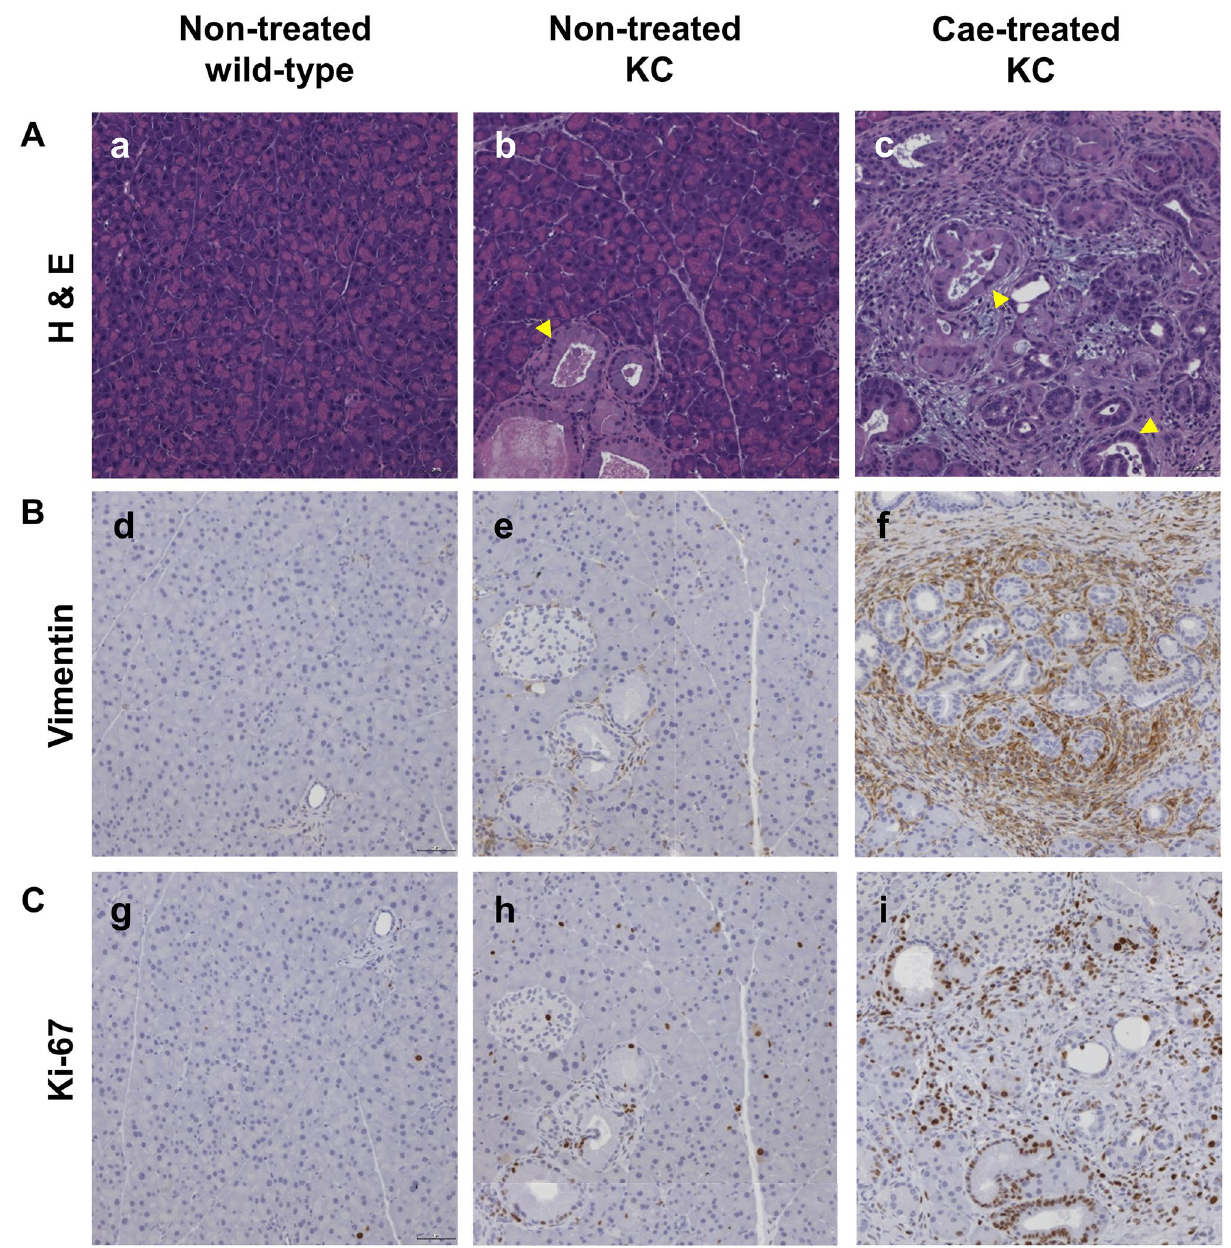
Figure 2. General pathological characteristics of PanIN lesions in a genetically engineered mouse model. Different staining images of pancreas histology at 10 × magnification in non-treated wild-type mice (n = 3), non-treated LSL-Kras G12D ; PDX-1-Cre (KC) transgenic mice (n = 4), and caerulein-treated KC transgenic mice (n = 5). ( A ) H&E stained section of the pancreas shows architectural and cytological changes of the smaller duct, including tall columnar cells (arrow), papillary formations, variation in nuclear size (pleomorphism), and nuclear hyperchromasia in KC transgenic mice (b, c). ( B ) Vimentin is mainly expressed around the pancreas duct and the surrounding area in KC transgenic mice (e, f). ( C ) Increasing Ki-67 positive acinar cell number is observed in KC transgenic mice (h, i). Cae, caerulein; H&E, Hematoxylin and eosin; KC , LSL-Kras G12D/- ; PDX-1- Cre transgenic mice; PanIN, pancreatic intraepithelial